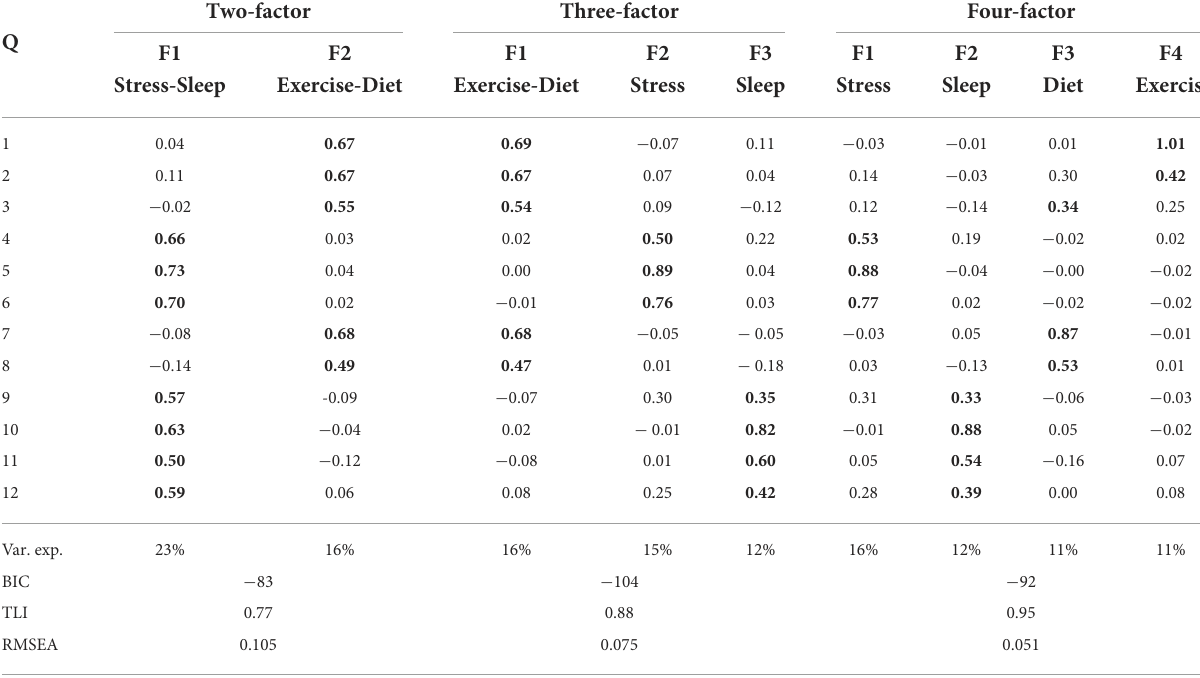
TABLE 4 Results of exploratory factor analysis on the same randomly selected subset of data used for VAE.